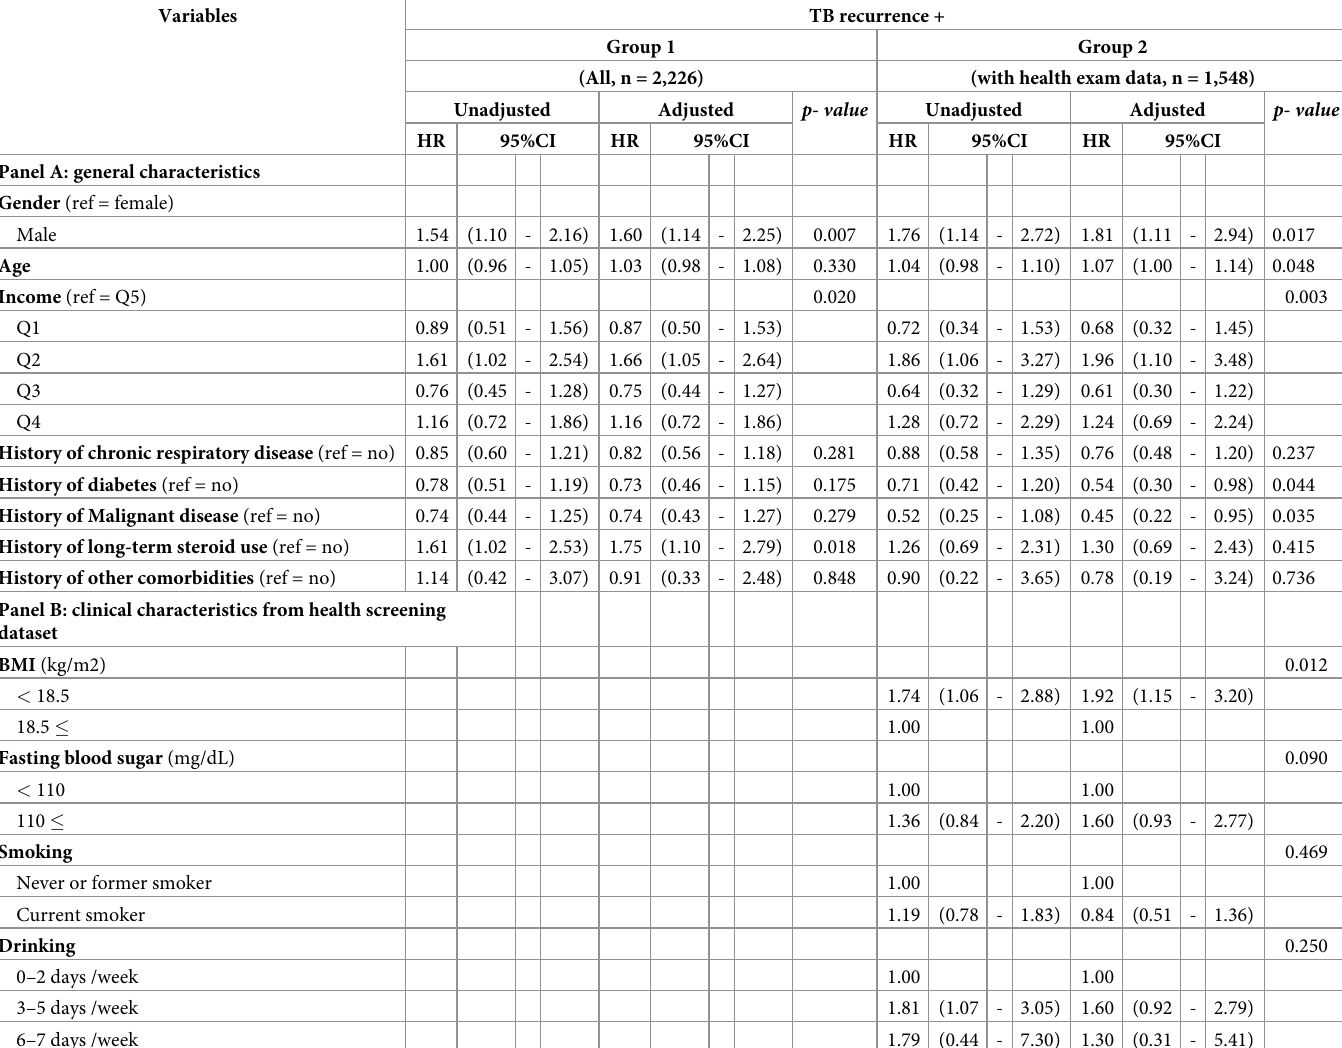
Table 3. Risk factors associated with TB recurrence.